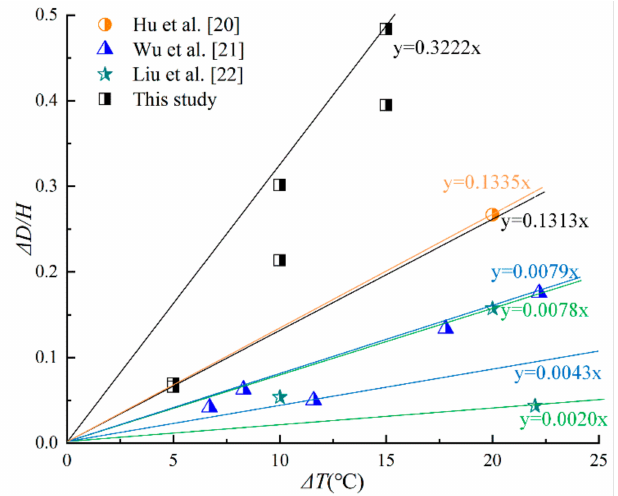
Figure 10. The relationship between ∆ D/H and ∆